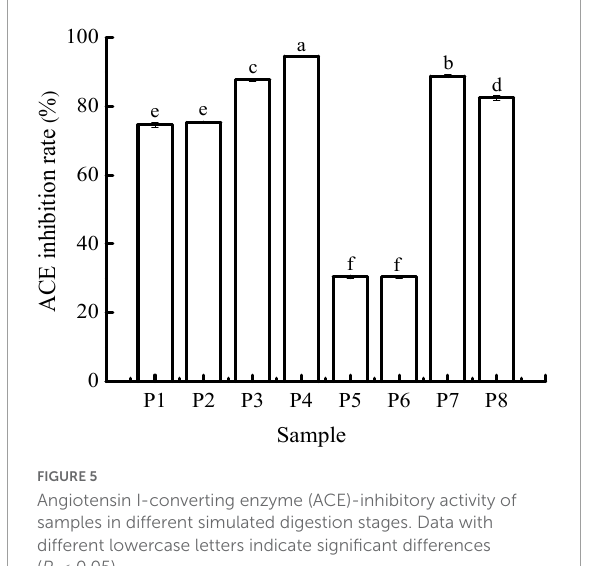
FIGURE5 Angiotensin I-converting enzyme (ACE)-inhibitory activity of samples in different simulated digestion stages. Data with different lowercase letters indicate significant differences ( P < 0.05).